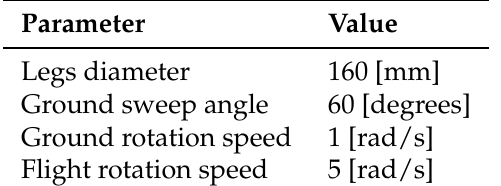
Table 5. CLHeRo parameters for tests at indoor scenario 1.